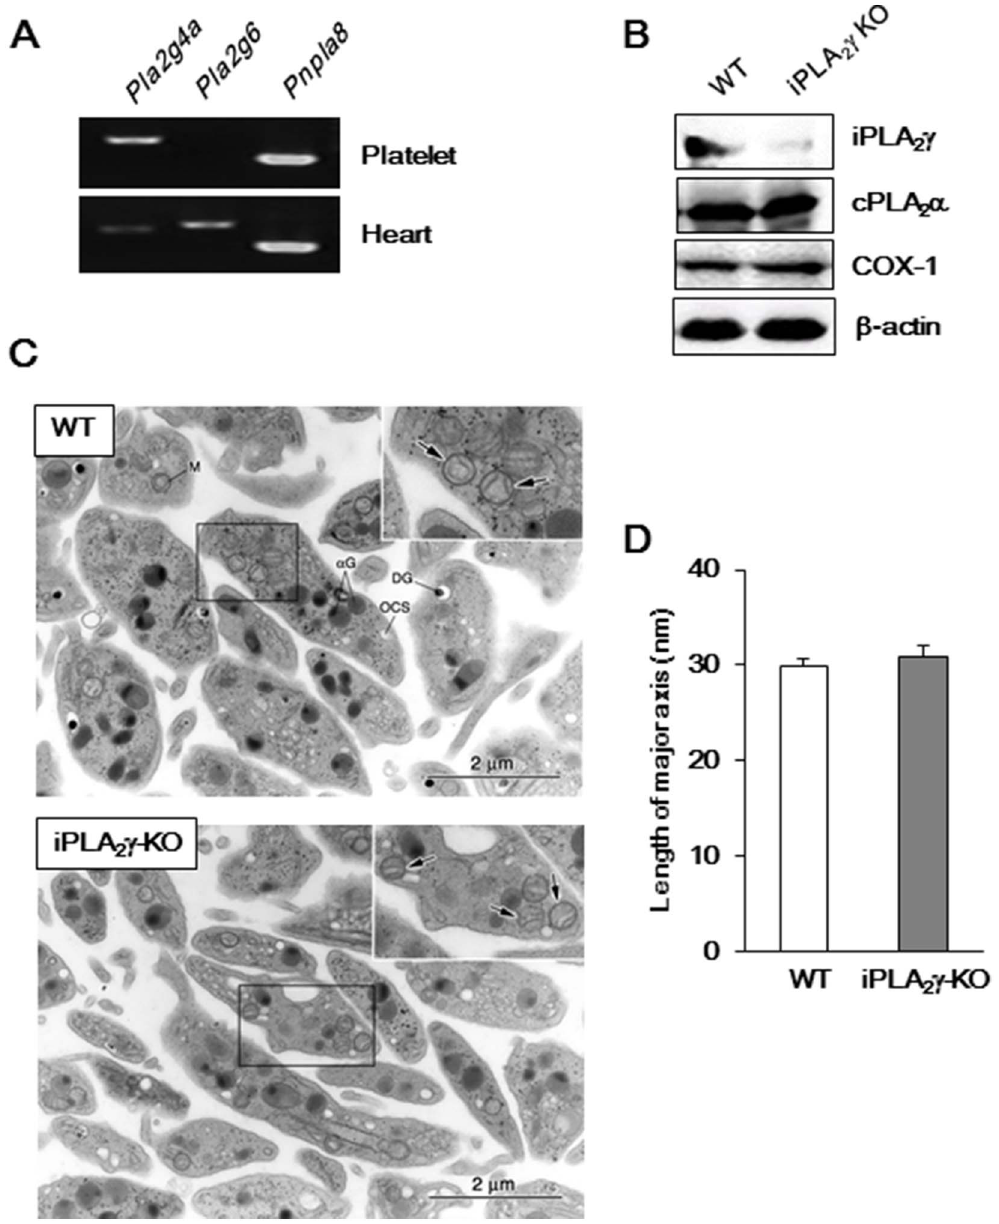
Figure 1. Expression of iPLA 2 c in platelets and morphological features of iPLA 2 c -KO mouse platelets. (A) RT-PCR analysis of cPLA 2 a (Pla2g4a), iPLA 2 b (Pla2g6) and iPLA 2 c (Pnpla8) mRNA expressions in platelets (upper panel) and heart (lower panel). (B) Immunoblot analysis of iPLA 2 c cPLA 2 a and COX-1 expression in WT and iPLA 2 c -KO platelets. b -actin was used as a loading control. (C) Images of WT (upper panel) and iPLA 2 c -KO platelet (lower panel) ultrastructure obtained by electron microscopy. M, mitochondrion; OCS, open canalicular system; a G, a -granules; DG, dense granule. Boxed areas are magnified in the upper right corners. Arrows indicate mitochondria. Representative results of at least three experiments are shown (A–C). (D) The length of the major axis of mitochondria in platelets from WT (open column) and iPLA 2 c -KO mice (closed column). Results are the average length (nm) 6 SEM (n=3).